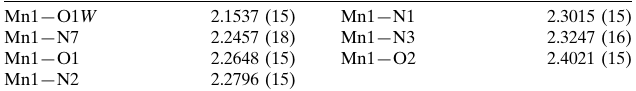
Selected bond lengths (A˚ ).